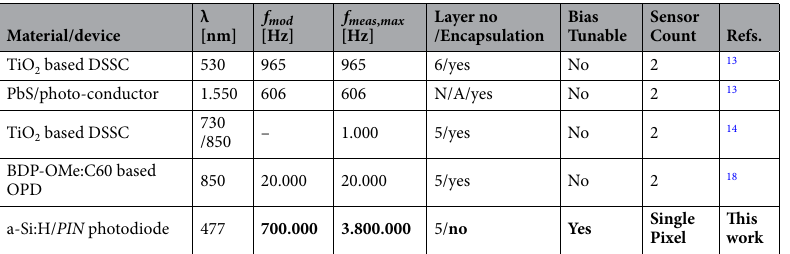
Table 1. FIP detector parameters and performance comparison including: material composition and detector type, illumination wavelength, maximum modulation f mod and measurement frequency f meas . max , number of required thin-film layers and encapsulation, bias tunability, and number of pixel required for 3D measurements.